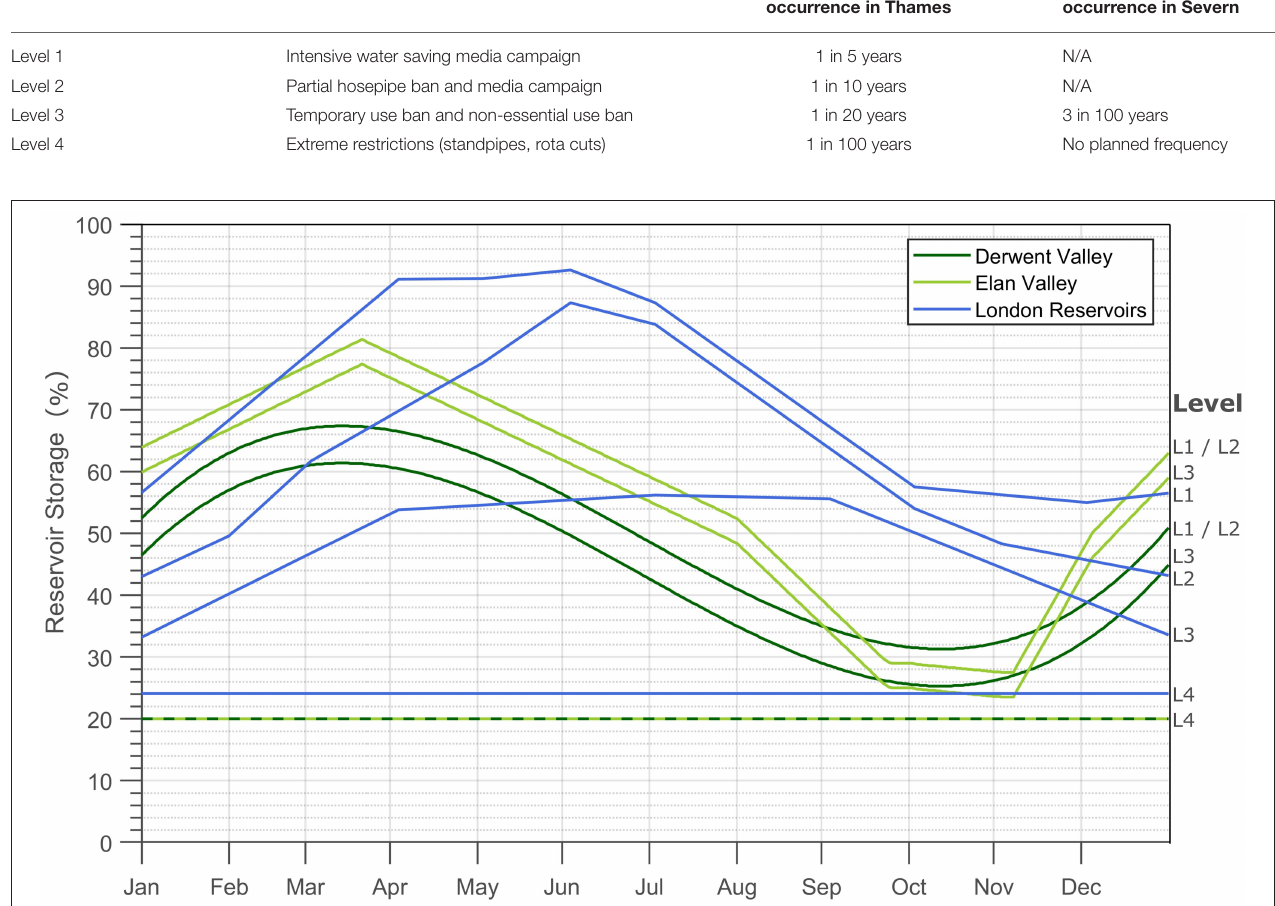
TABLE 3 | Example of levels of water use restrictions to customers in Thames Water and Severn Trent Water (Severn Trent, 2019; Thames Water, 2019a). Severity of restriction